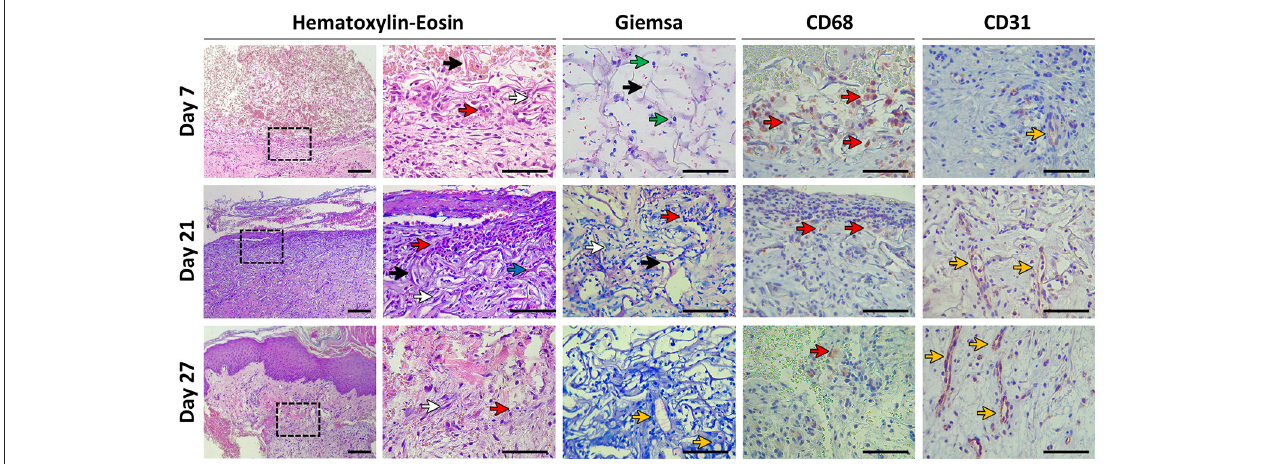
FIGURE 8 | Histological evaluation. Biopsies were taken at days 7, 21, and 27 post-scaffold implantation. Histomorphology was evaluated with Hematoxylin-Eosin and Giemsa staining. Immunohistochemistry was performed to study the presence of macrophages (CD68) and endothelial cells (CD31). Colored arrows indicate: collagen fibers (black arrows), fibroblasts (white arrows), immune cells (red arrows), fibrin deposits (blue arrow), microalgae (green arrows), and vascular structures (yellow arrows). The indicated area in the left column of Hematoxylin-Eosin is magnified in the right column. Scale bars represent 100 µ m for all pictures except for Hematoxylin-Eosin left column which represents 200 µ m. All samples correspond to P8, except for Giemsa (P1).